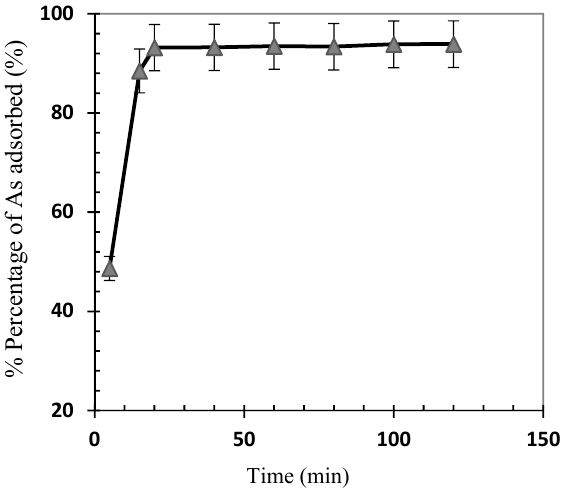
Figure 6. E ff ect of contact time on arsenic removal e ffi ciency (initial arsenic concentration: 0.075 g / L, Figure 6. Effect of contact time on arsenic removal efficiency (initial arsenic concentration: 0.075 g/L, sorbent dosage: 2 g / L, agitation rate: 150 rpm, pH = 6). sorbent dosage: 2 g/L, agitation rate: 150 rpm, pH = 6).